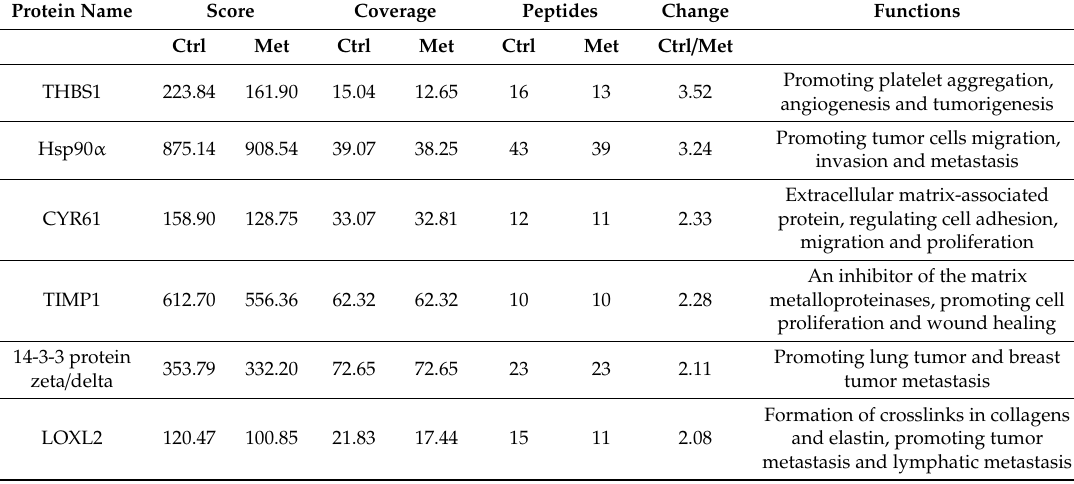
Table 1. Relative protein concentration in conditioned medium changed more than twofold after metformin treatment ( < 2.0) measured by MS.